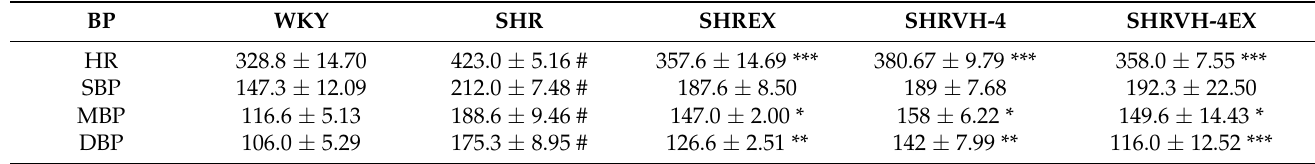
Table 1. Effect of VH-4 bioactive peptides and exercise on hemodynamic